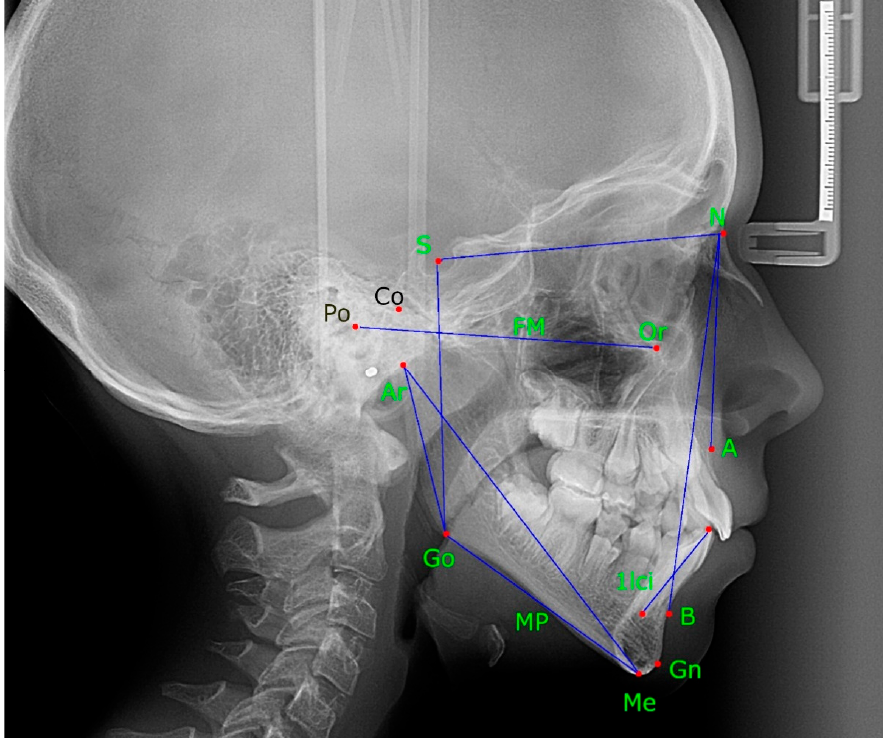
Figure 1. Lateral cephalogram–anthropometric landmarks and lines. S, sella; N, nasion; SNA, the angle between sella, nasion and point A; SNB, the angle between sella, nasion and point B; ANB, the angle between point A, and point B; Go, gonion; Co, condylion; Ar, articulare; Gn, gnathion; Po, porion; Me, menton; 1lci, 1 lower central incisor; NB, nasion point B line; FM, Frankfurt plane; MP, mandibular